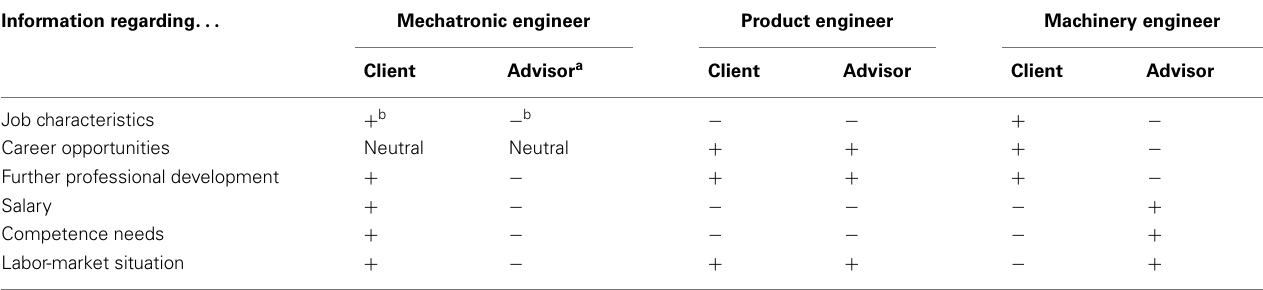
TableA1 | Information regarding the job alternatives differentiating between supporting and conflicting information regarding the client’s and the advisor’s